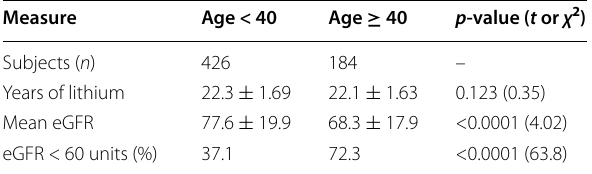
Table 7 Patients started on lithium treatment below or